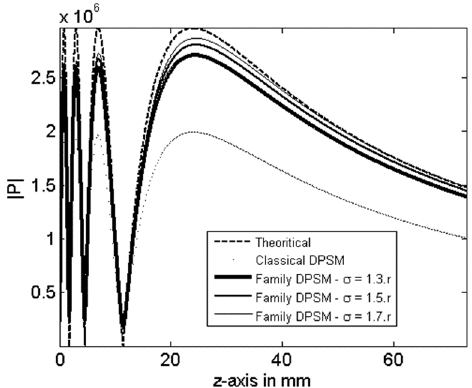
Figure 10. The normal velocity variation on the transducer surface: dashed line—true value; dotted line—computed by superimposing individual point source contributions, as shown in Figure 1; solid lines—computed results using source clusters, as shown in Figure 3, for three different radiation patterns.